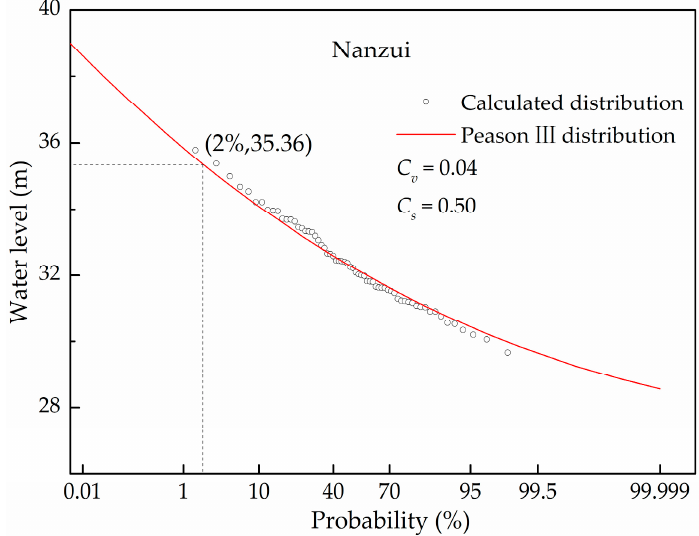
Figure 13. The probability of the maximum water level at Nanzui stationby fiting Peason III distribution (1950–2014).